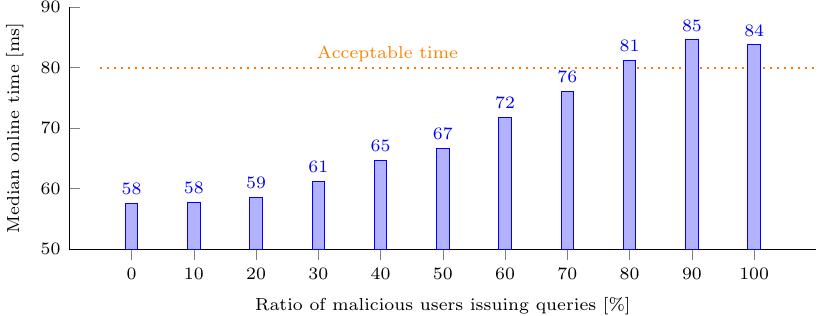
Figure 12. Median online time for different ratio of queries issued by malicious users among a total of 50 users. Compared with the acceptable detection time defined in Section